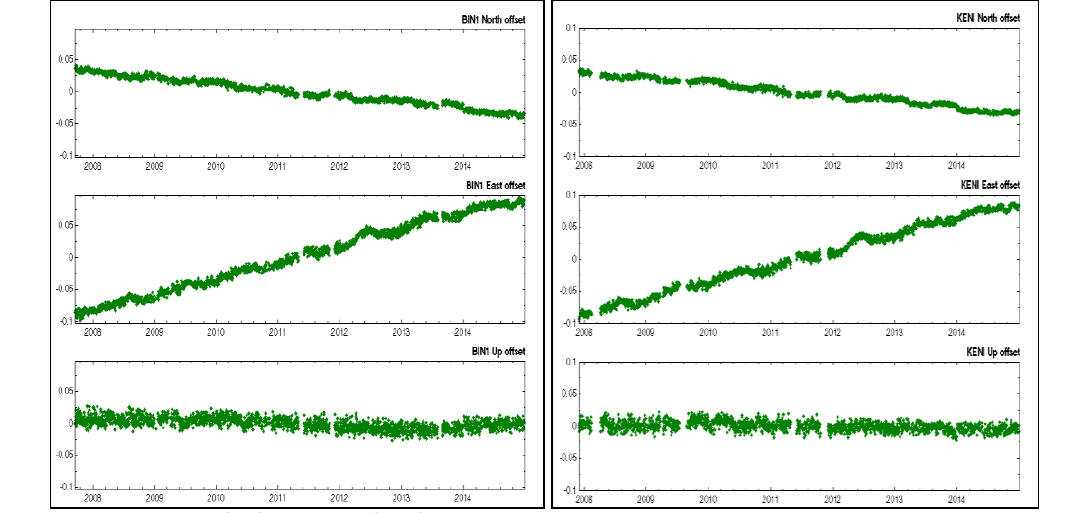
Figure 3. Time series of BIN1 (left) and KENI (right) MyRTKnet stations located in Sarawak and Sabah, respectively. Only the 2012 earthquake has a slight effect (few mm) on the east component in East Malaysia which can be considered negligible. Many East Malaysia MyRTKnet stations began operating towards the end of 2007, with mostly being established in April 2009